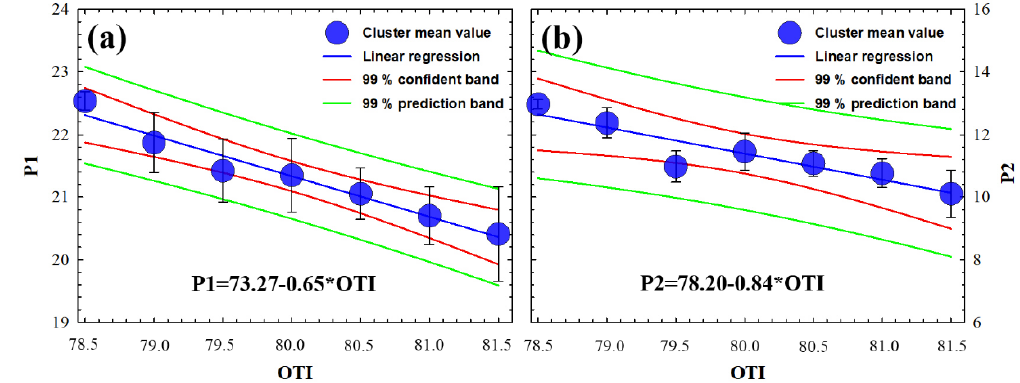
Figure 7. Mean clustered OTI values as function of first ( a ) and second applanation pressures ( b ) at the ORA device for all subjects. Standard deviation of the clustered data, equations, confidence, and prediction bands of the regression analysis are included.